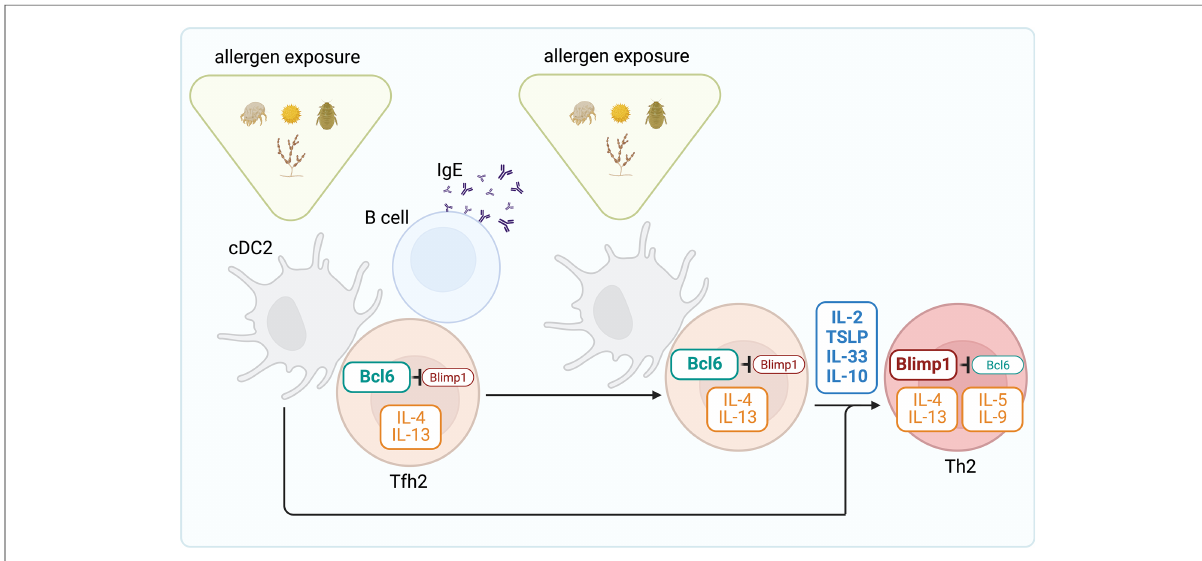
FIGURE 2 Steps toward generating effector Th2 cell responses to allergens. During the sensitization phase, cDC2s prime allergen-speci fi c Tfh2 cell responses in the draining lymph node. Through interactions with B cells, Tfh2 cells promote IgE secretion. Following allergen re-exposure, Tfh2 cells differentiate into effector Th2 cells that subsequently migrate to the lung and promote allergic airway in fl ammation. Tfh2 cell development depends on the expression of the transcription factor Bcl6, which functions as a transcriptional repressor that prevents Blimp1 expression